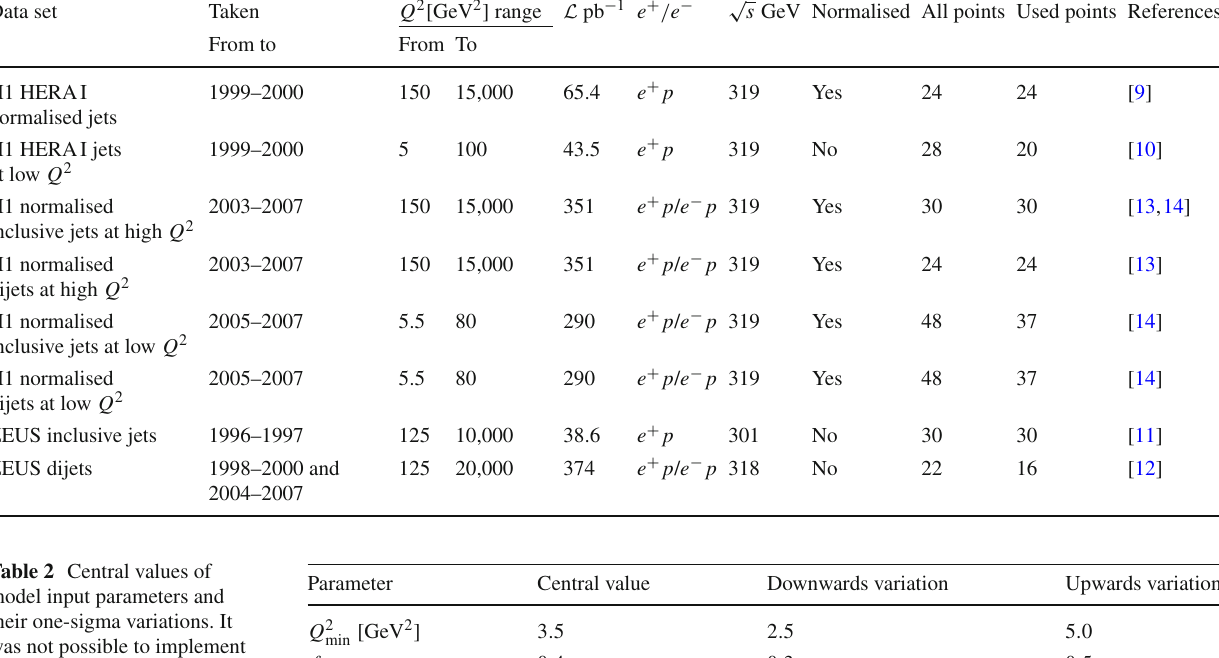
Table 1 The jet-production data sets from H1 and ZEUS used for the HERAPDF2.0Jets NNLO fits. The data were used as published by the collaborations. The term normalised indicates that these cross sections are normalised to the respective neutral current inclusive cross sections Data set Taken